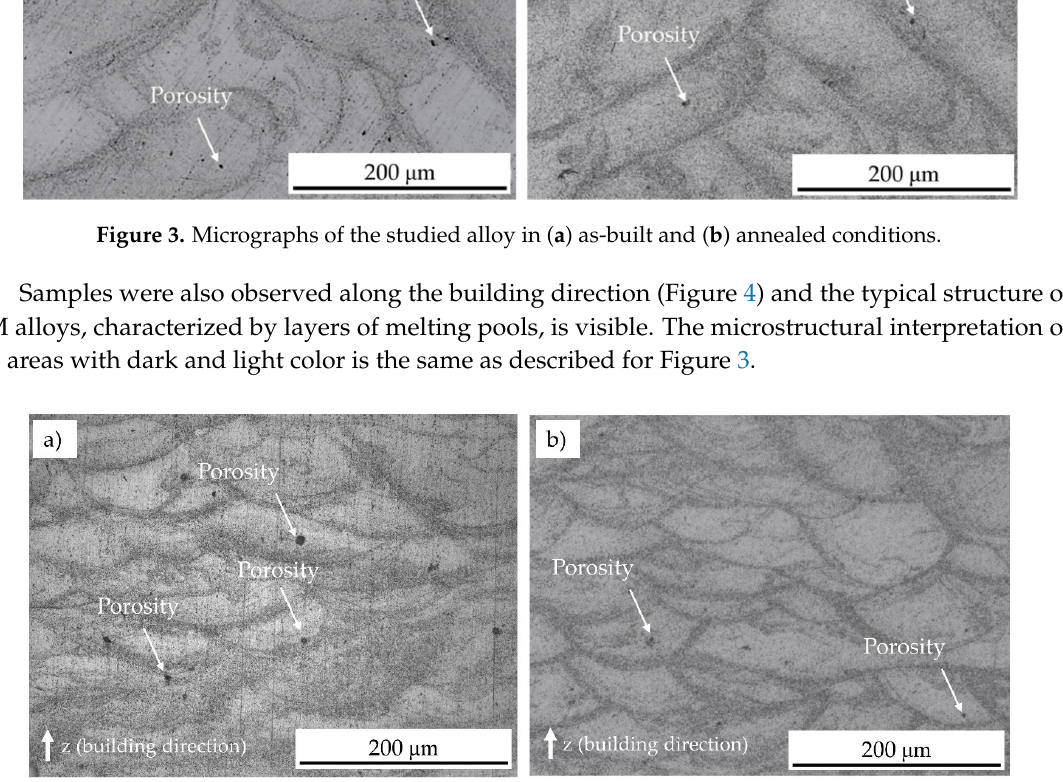
Figure 4. Micrographs of the studied alloy in ( a ) as-built and ( b ) annealed conditions.